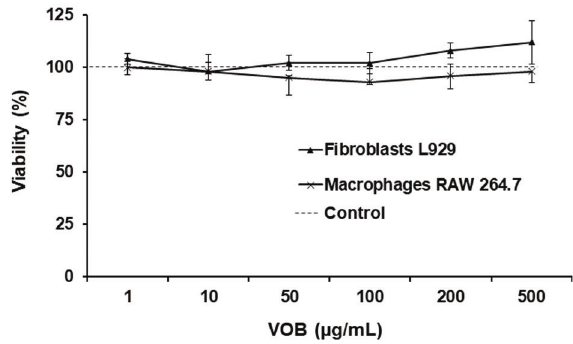
Figure 1. Cellular viability of fi broblasts and macrophages after 24 h exposure with 1 to 500 m g/mL vegetable oil blend (VOB) solution by the colorimetric MTT assay. Data are reported as mean ± SE percentage of cellular viability compared to basal control cells of three independent experiments.